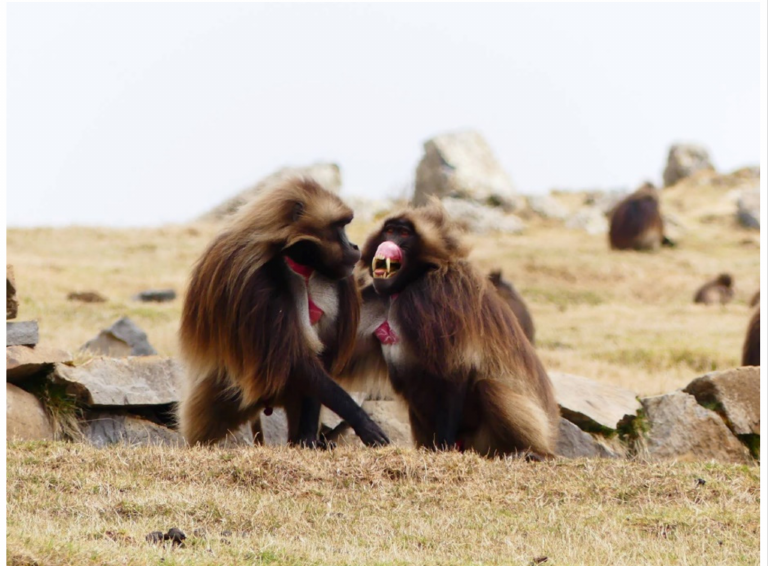
Figure 2. Post-conflict interaction between two adult males belonging to a bachelor group (Amhara region, Ethiopia). The subject on the right side is performing a lip-flip, a facial expression indicating benign intent. Photo: Elisabetta